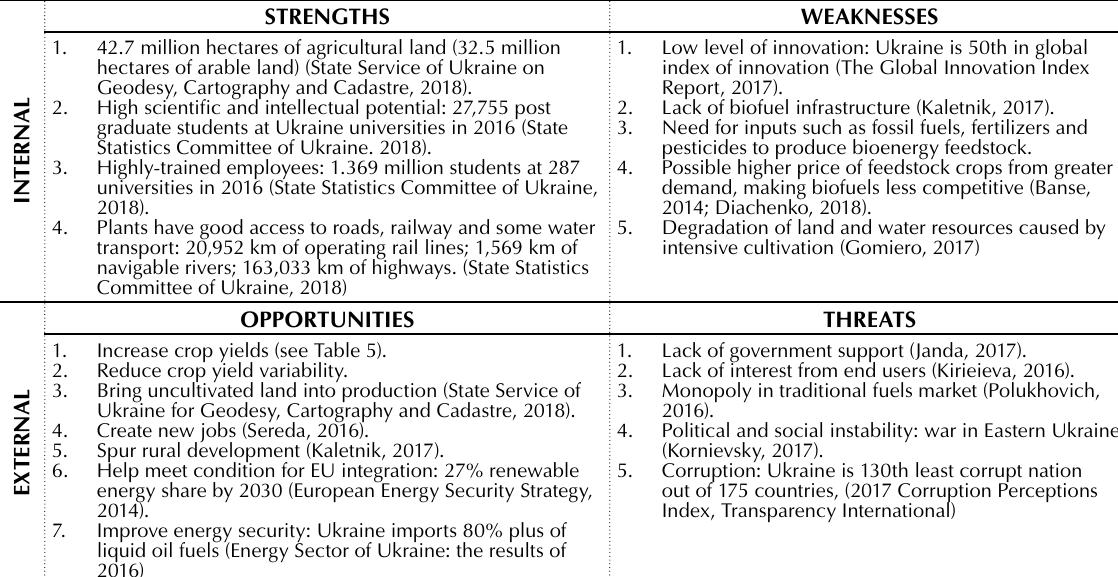
Table 6. SWOT analysis of biofuels industry development in Ukraine STRENGTHS